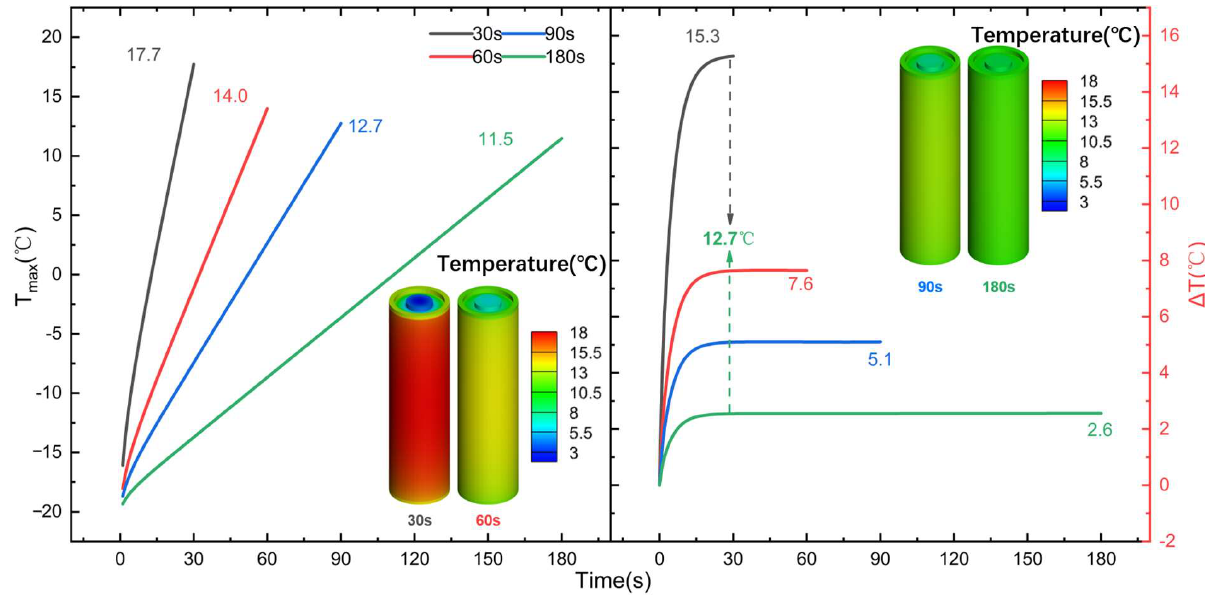
Figure 14. Distribution of the internal temperature and surface temperature of the cell at different heating times (heating power) under side heating: Maximum temperature ( Left ); Temperature difference ( Right ).